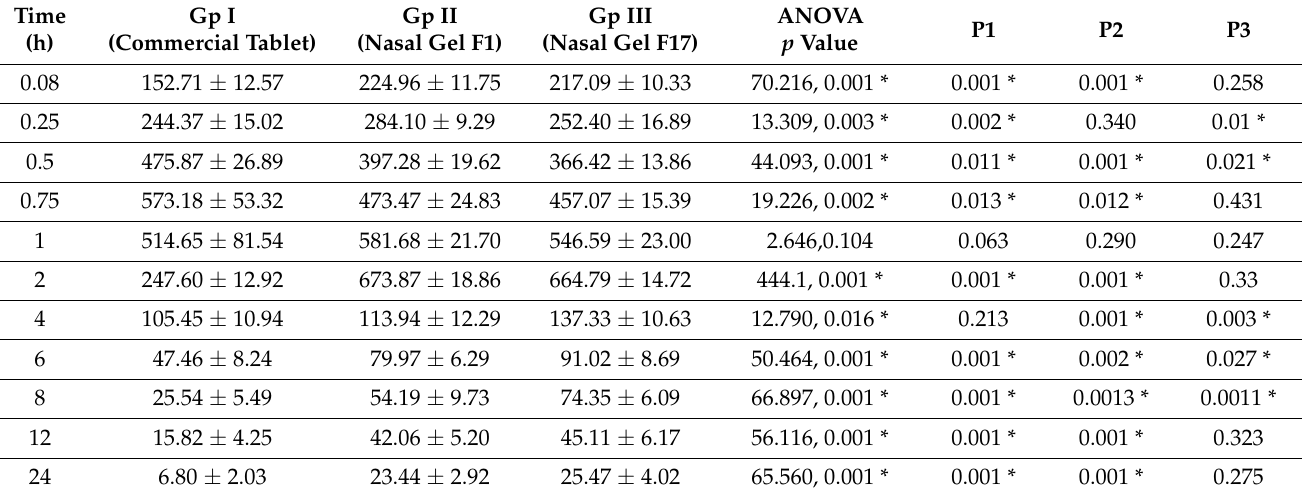
P1 comparison between commercial tablet and nasal gel (F1) ; P2 comparison between commercial tablet and nasal gel (F17); P3 comparison between nasal gel (F1) and nasal gel (F17); * Significant difference.